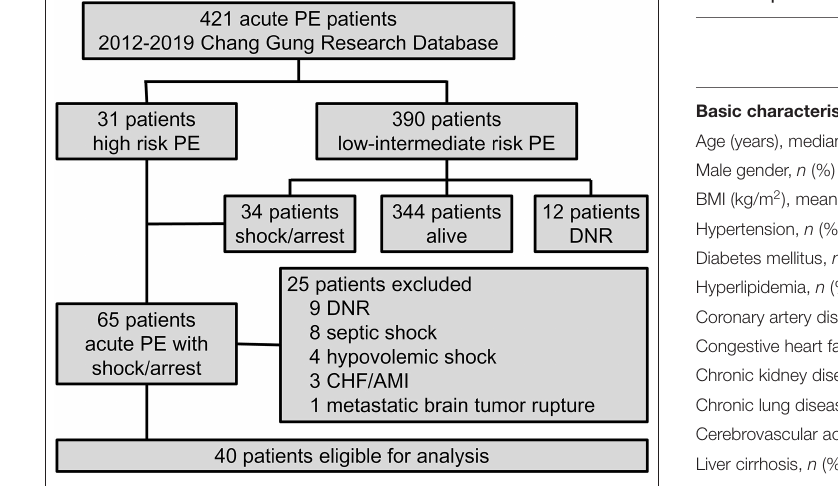
TABLE 1 | Baseline clinical and demographic